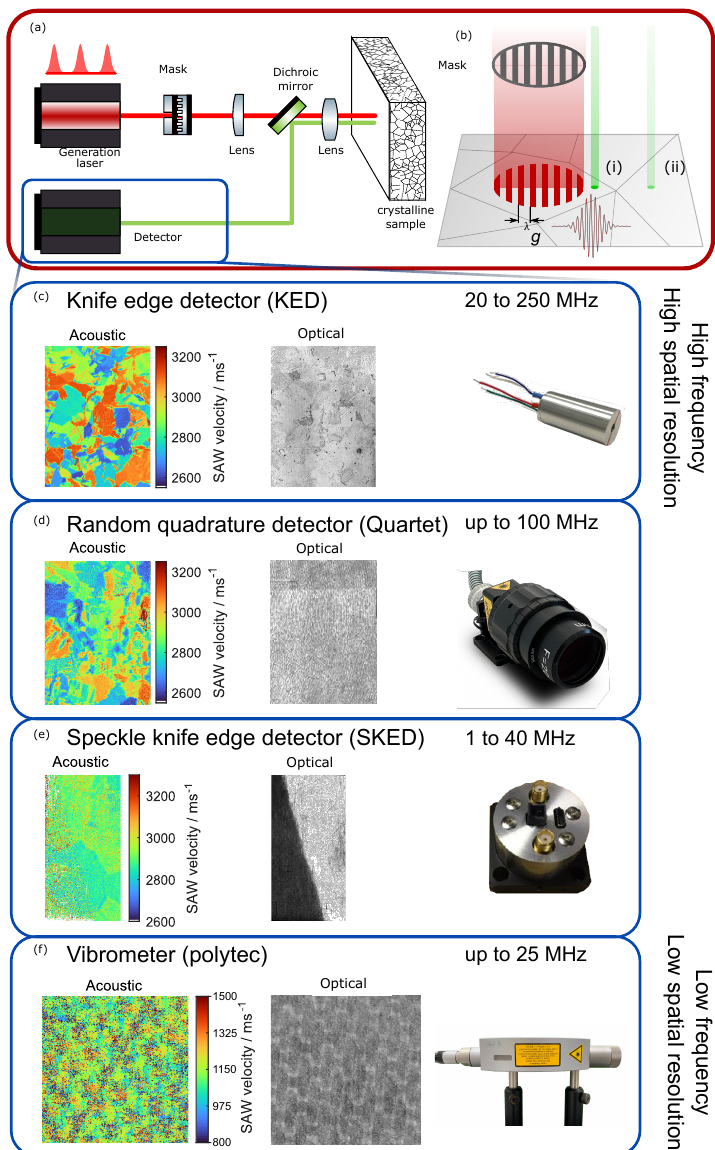
Figure 2. SRAS can be used with a variety of detectors, depending on the sample and surface finishing to be interrogated. ( a ) shows generalised schematic of the optical system and sample to be scanned, where the detector may take the form of a commercial system with integrated laser and detector, or a bespoke configuration separating the input laser and detector into two arms. ( b ) shows the area of interest on the sample surface, where the acoustic waves are generated under the imaged mask pattern and have wavelength λ g ; an example of the generated waveform is then shown propagating towards the detection position. As SRAS measures the frequency of the wavepacket—not the time of flight—the velocities determined at positions (i) and (ii) are the same, despite crossing a grain boundary. ( c – f ) then give examples of previous SRAS scans using different laser ultrasound